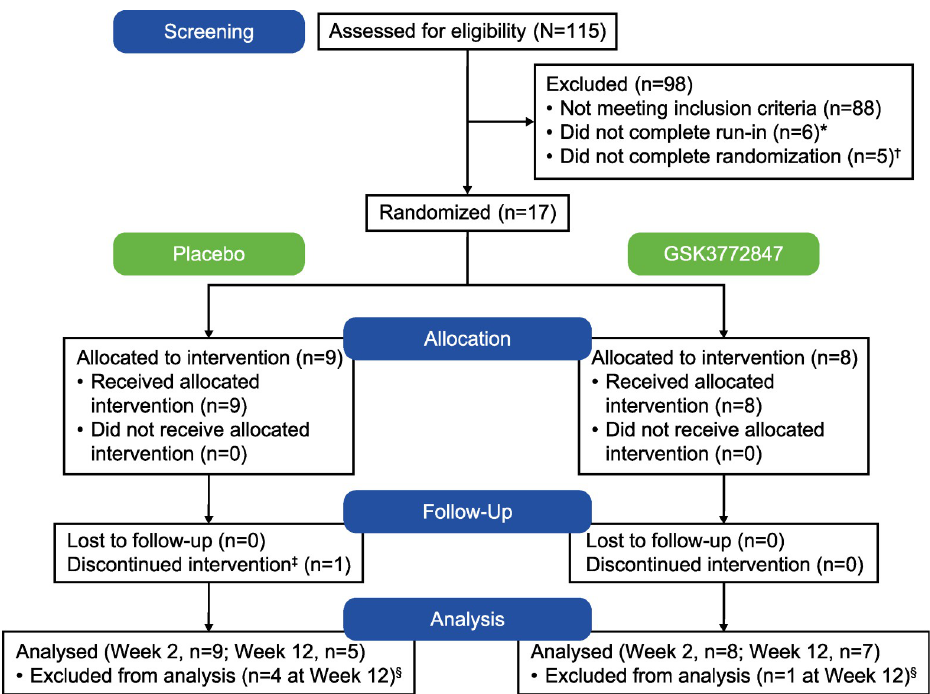
Fig 1. CONSORT flow diagram. � 1 patient withdrew; 5 patients did not meet continuation criteria. †1 patient within this group was subsequently re-randomized and went on to complete the study. ‡ Patient withdrew from the study (missed study visits). § Patients were excluded if they had the Week 12 assessment outside of the treatment end date (+28 days).